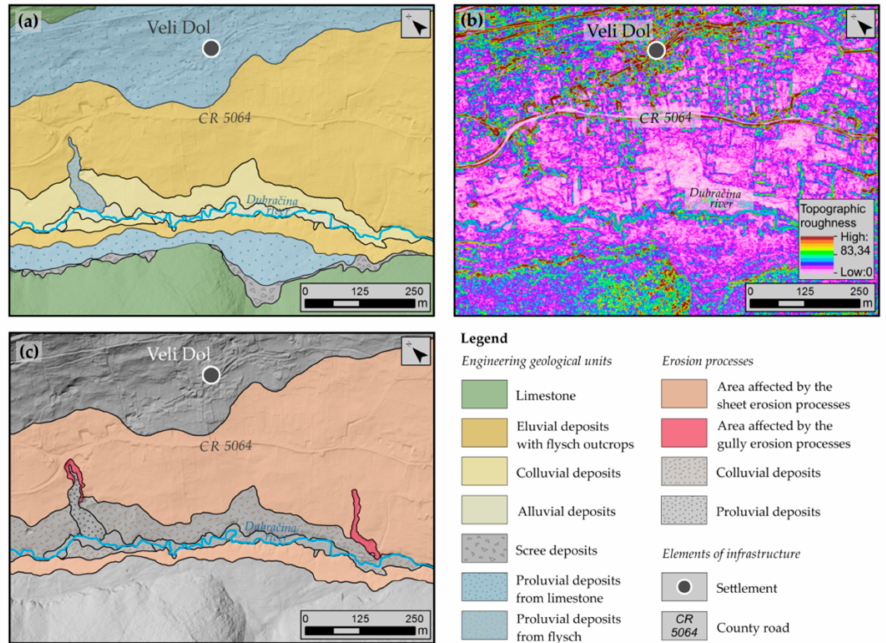
Figure 10. An example of identification and mapping of the sheet erosion processes: ( a ) a detail from the EGM 1:5000 [55]; and ( b ) a visualization of the same area on the topographic roughness map. ( c ) The hillshade map with delineated polygons representing areas a ff ected by the sheet erosion processes and areas a ff ected by the gully